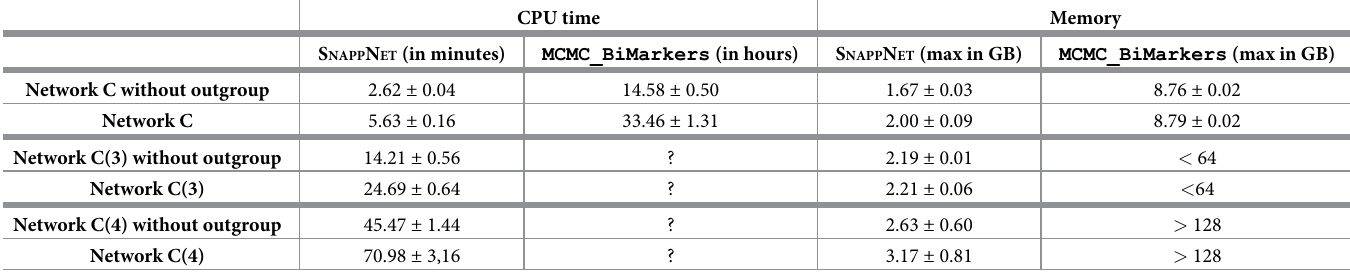
Table 4. Computational efficiency of calculating a single likelihood value in S NAPP N ET and MCMC_BiMarkers for networks C, C(3) and C(4). 10 lineages are sam- pled in species C and 1 lineage in other species. Average and standard deviation are